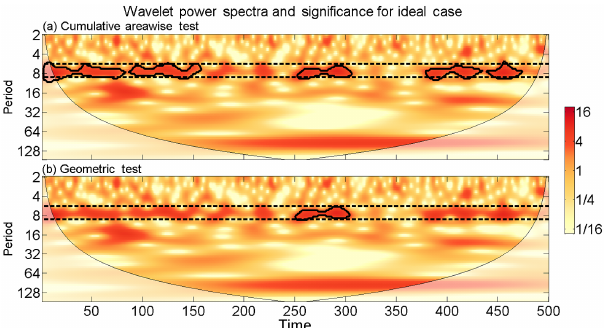
Figure 10. (a) Cumulative areawise test applied to a sinusoid with a frequency of 0.8 and amplitude equal to 0.8. Signal-to-noise ratio is 1.0. Contours represent patches that are elements of 5% significant pathways. Dotted lines represent the upper and lower boundaries of a theoretical patch obtained by generating the wavelet power spec- trum of a pure sine wave and calculating the width of the patch at t = 250. (b) Same as (a) except for the geometric test with α = 0 . 05 and α geo = 0 . 05. Contours represent patches that are geometrically